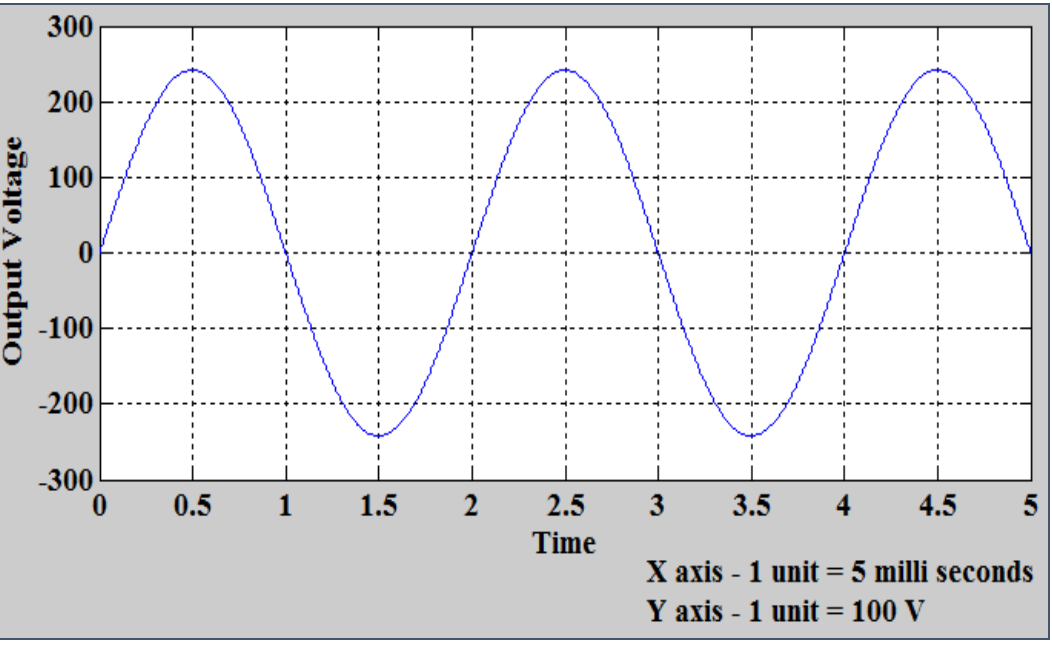
Figure 22. Output voltage vs. Time—RL load (100 + j31.4) ohm—Simulation.